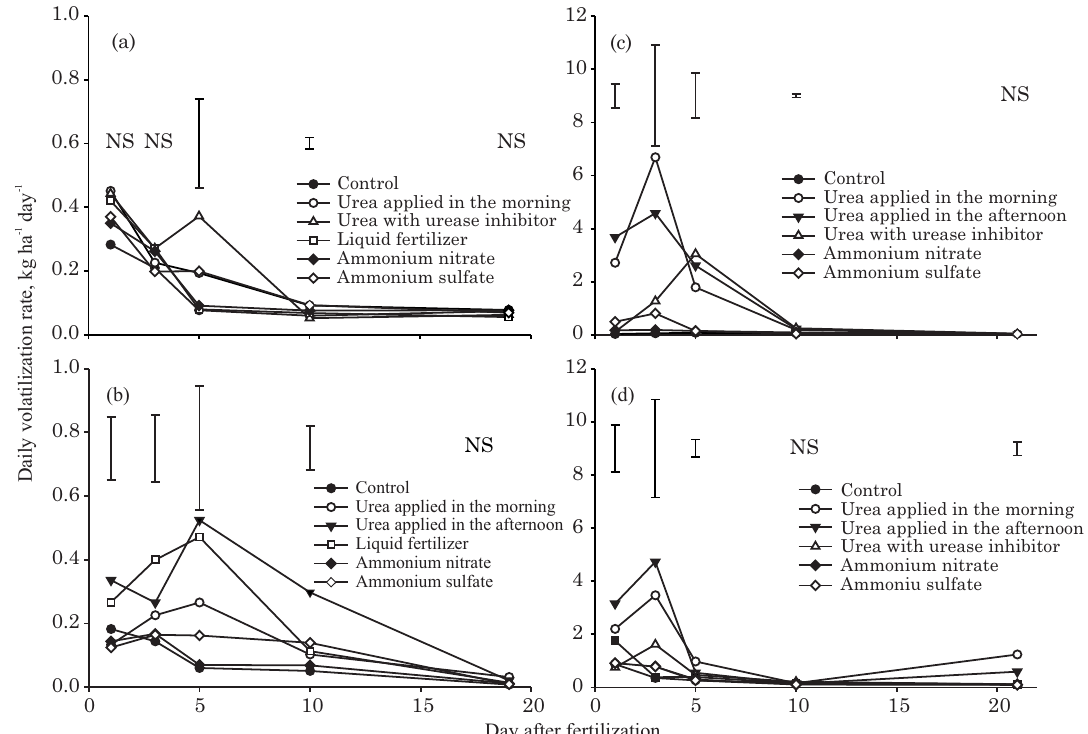
Figure 2. Daily volatilization rates recorded in the experiments with wheat [winters 2009 (a) and 2010 (b)] and maize [summers of 2009/10 (c) and 2010/11 (d)] in the south-central region of Paraná. Vertical bars indicate the least significant difference by Tukey’s test at 5 %. NS: not significant. The scale of the y-axis of figures representing winter (a, b) and summer (c, d) are